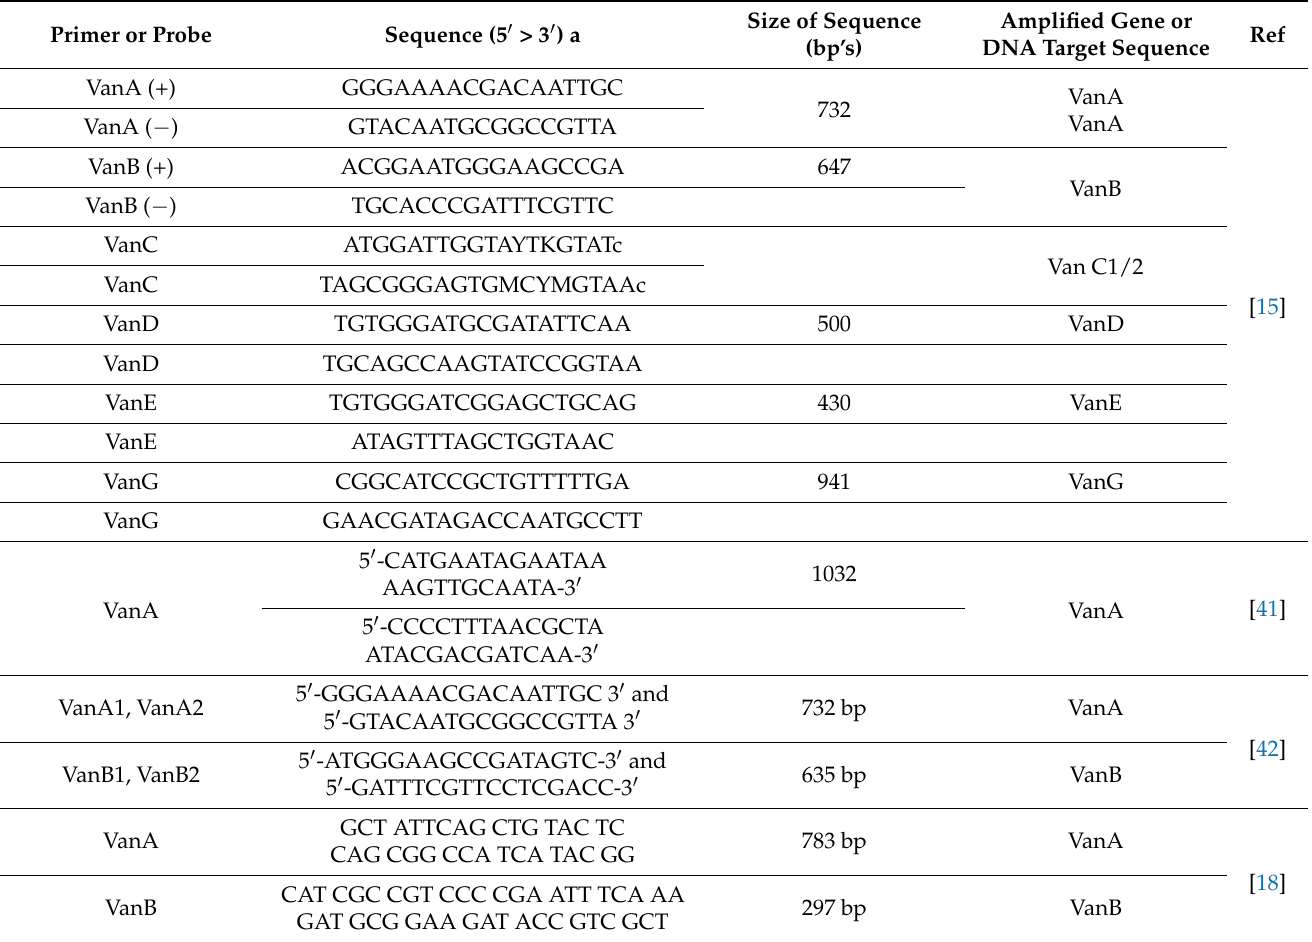
Table 1. PCR primers and DNA probes used for the detection of VRE